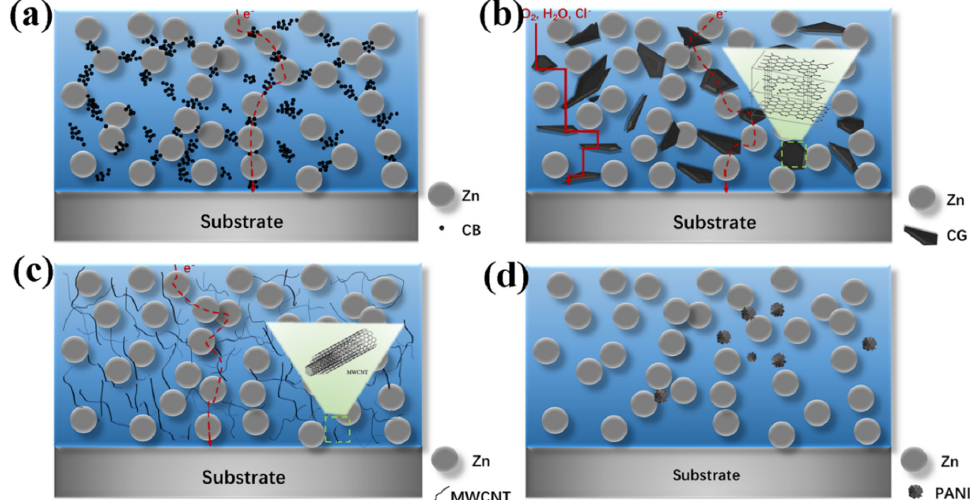
Figure 9. Schematic representation of anti-corrosion mechanisms in conductive additive modified zinc-rich epoxy coatings: ( a ) XCB-YZn, ( b ) XCG-YZn series, ( c ) XMWCNT-YZn series and ( d ) XPANI-YZn series.